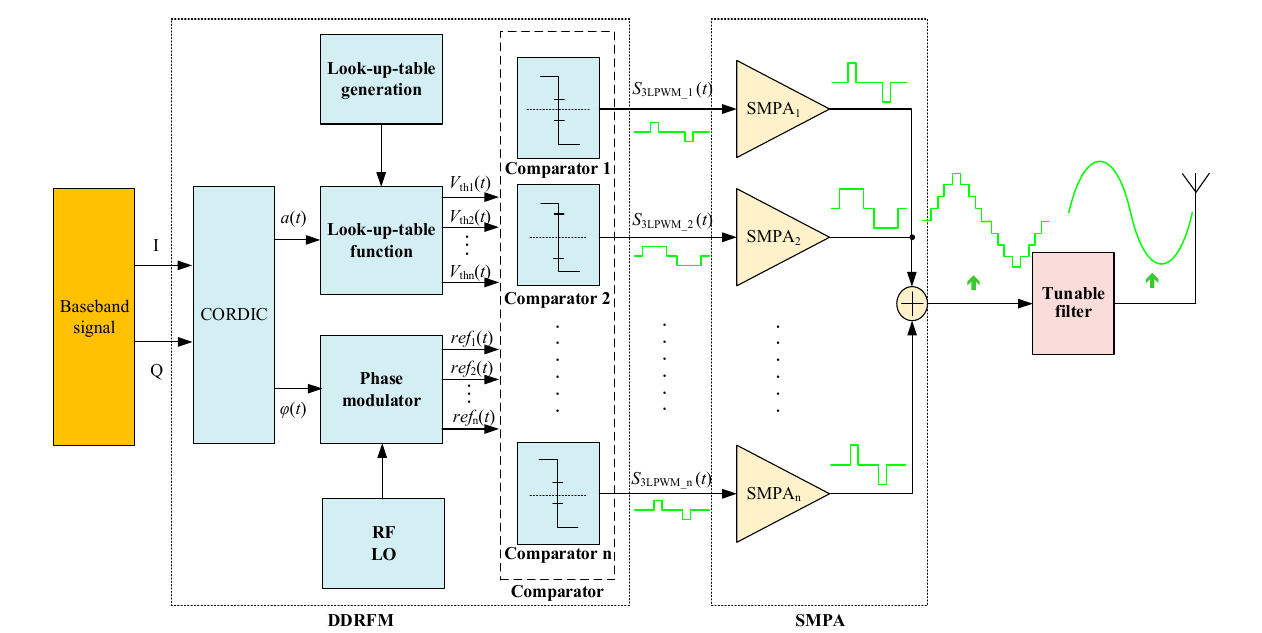
Figure 1. Diagram of ADTx structure based on RF-PWM.